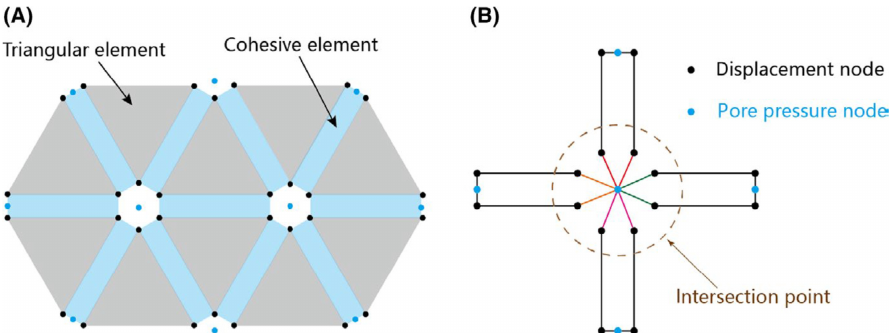
Figure 12. The schematic of the discretization and elements for CZM. ( A ) The mesh discretization for CZM. ( B ) The connectivity of cohesive elements. Reprinted from Ref. [238].